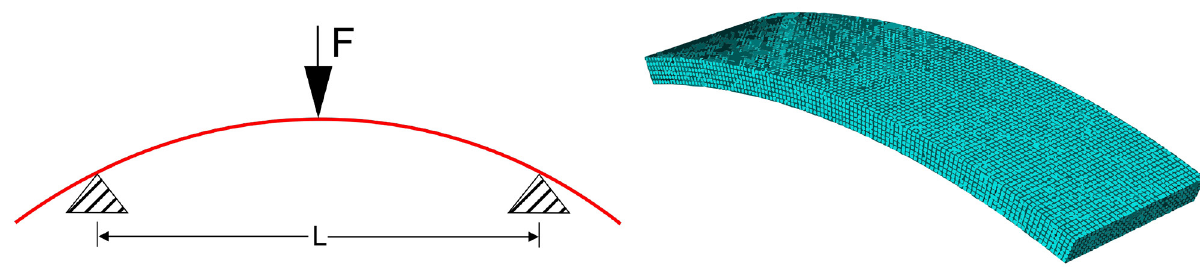
Figure 7: Static scheme (L=16h, see Fig.